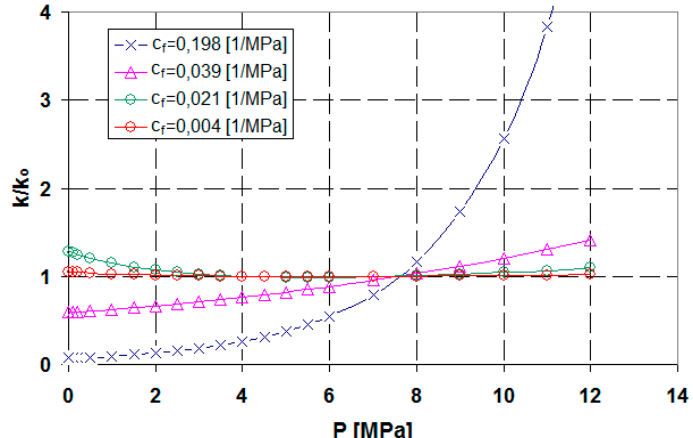
Figure 6. Changes in the Mannville Group coal permeability in relation to changes in the methane pressure based on the Cui and Bustin model [3]. 298